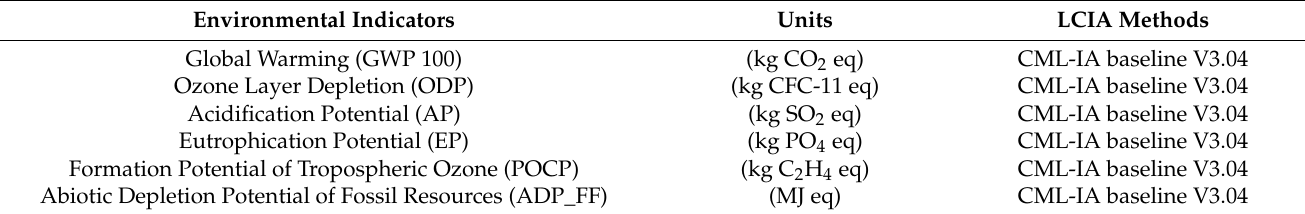
Table 7. Indicators, units, and life cycle impact assessment (LCIA) methods. Environmental Indicators Units LCIA Methods Global Warming (GWP 100) (kg CO 2 eq) CML-IA baseline V3.04 Ozone Layer Depletion (ODP) (kg CFC-11 eq) (kg SO 2